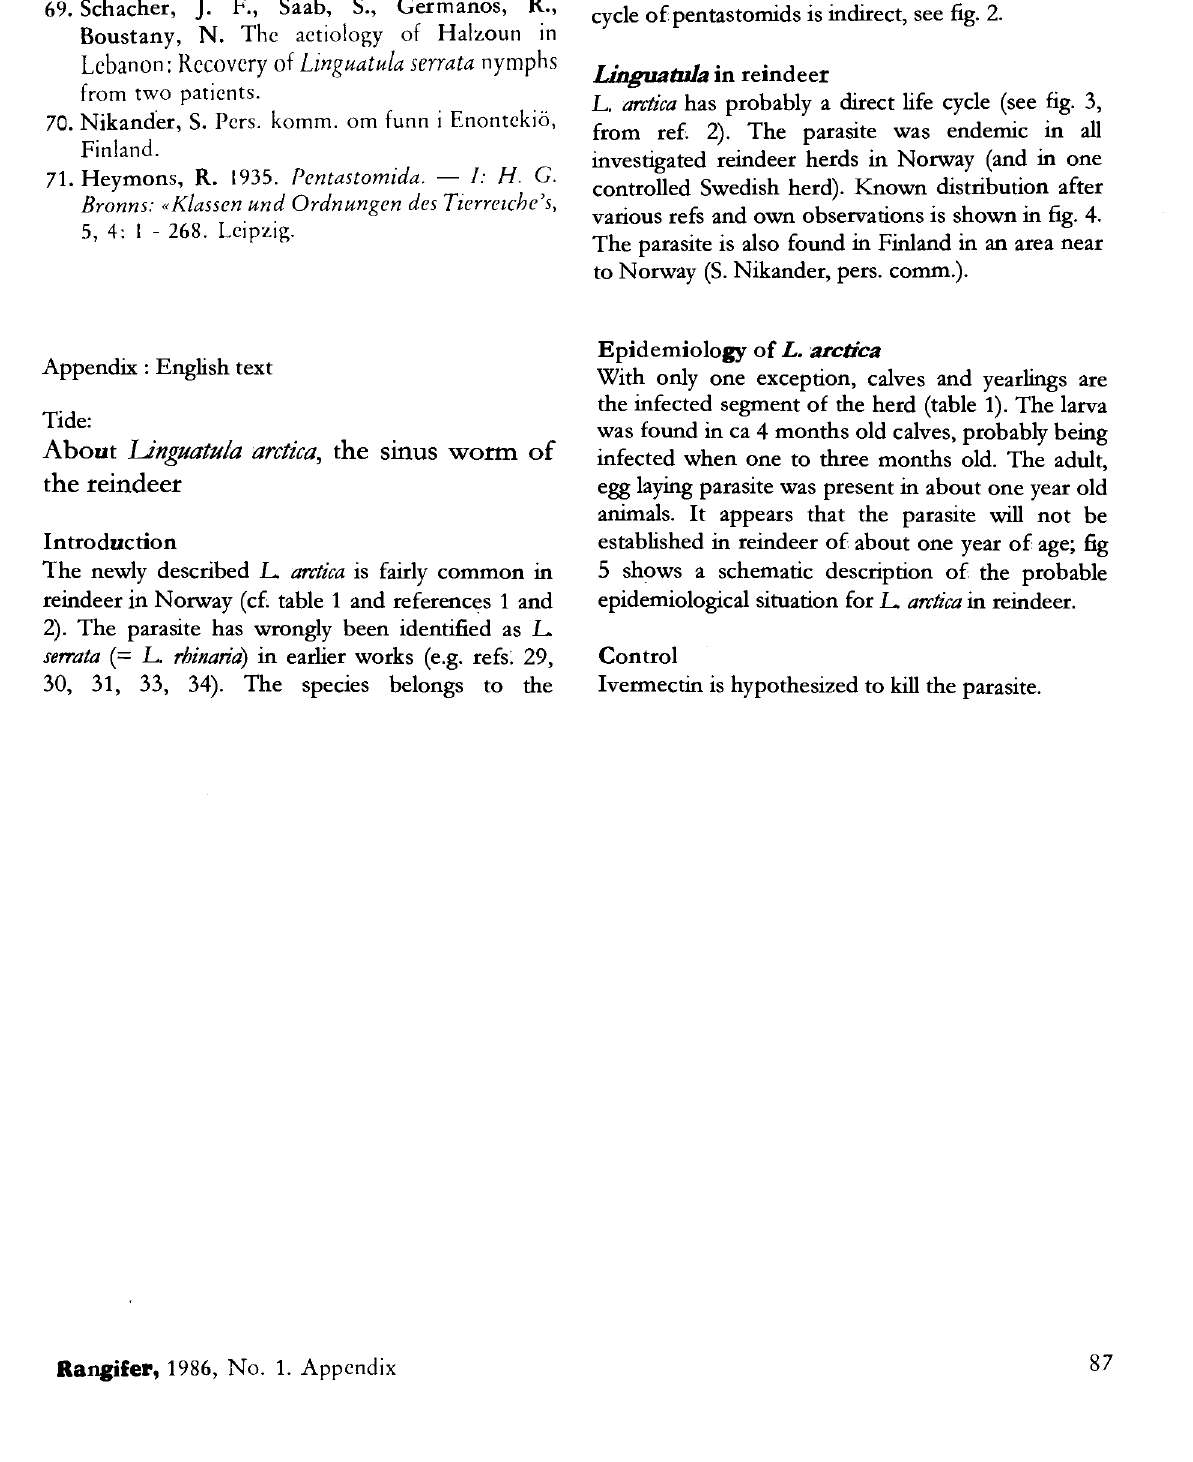
Table 2 indicates the intermediate and final host species used by pentastomids. L. serrata has been found in Sweden (ref. 23) and Denmark (refs. 24, 25), but not in Norway and Finland. The general life cycle of pentastomids is indirect, see fig. 2. Linguatula in reindeer L. arctica has probably a direct life cycle (see fig. 3, from ref. 2). The parasite was endemic in all investigated reindeer herds in Norway (and in one controlled Swedish herd). Known distribution after various refs and own observations is shown in fig. 4. The parasite is also found in Finland in an area near to Norway (S. Nikander, pers.